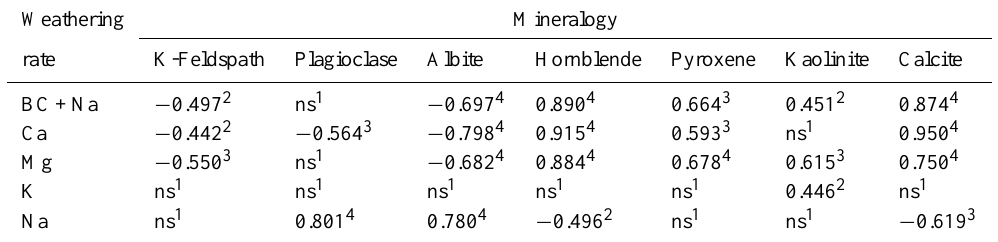
Table 5. Correlation coefficients ( r ) between ions weathering rates and soil mineralogy. No significant relationship was observed between garnet, biotite, muscovite, Fe-chlorite, Mg-vermiculite, and apatite and any of ions weathering rates.